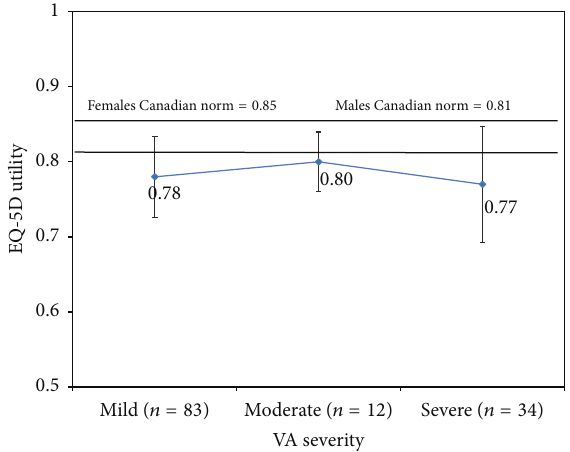
Figure 3: Mean EQ-5D utility scores and 95% confidence intervals at 6 months by visual acuity